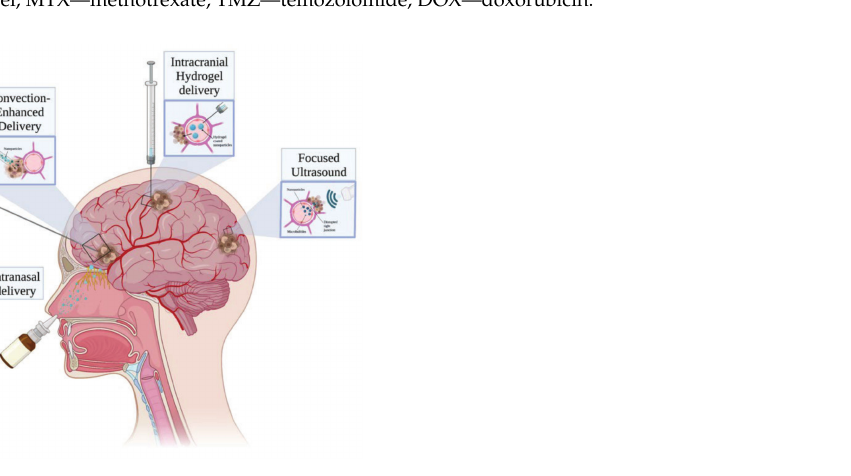
Figure 6. Administration routes for polymeric nanoparticles in the treatment of GBM. Reprinted with permission from Ref. [92]. Copyright 2022